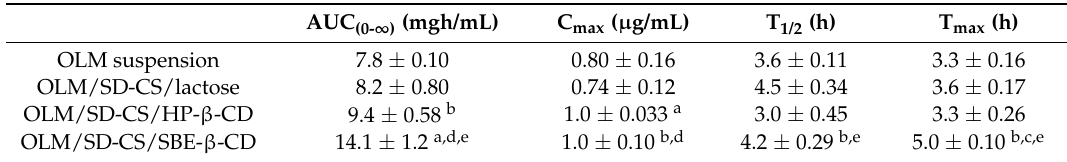
Table 1. Pharmacokinetic parameters for olmesartan tablets (OLM) in rats following oral administration of the suspensions (8 mg/kg as the drug).